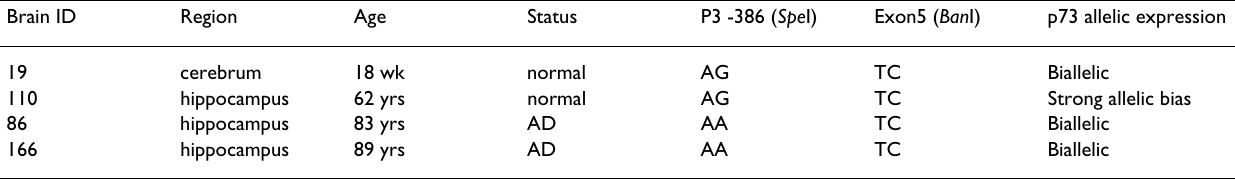
Table 8: Genotypes of the four informative brains examined for TP73 allele-specific mRNA expression Brain